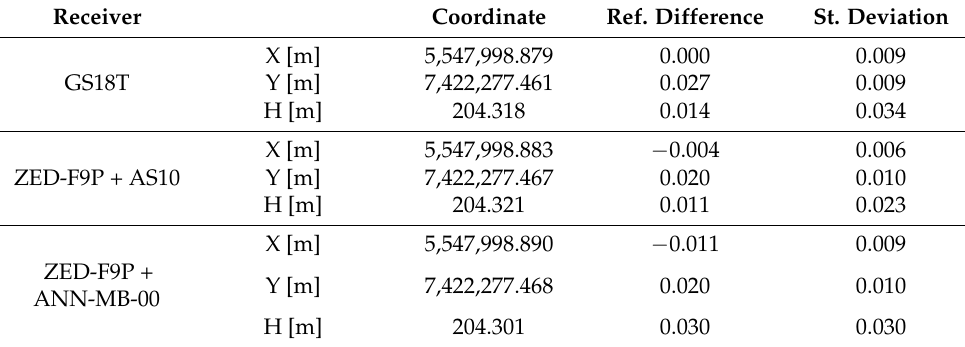
Table 4. Measurement results on Pt 3.